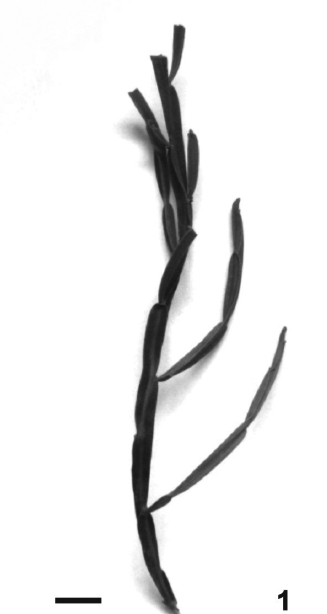
FIGURA 1 – Baccharis microcephala DC. – Ramo reprodutivo. Barra = 2 cm.